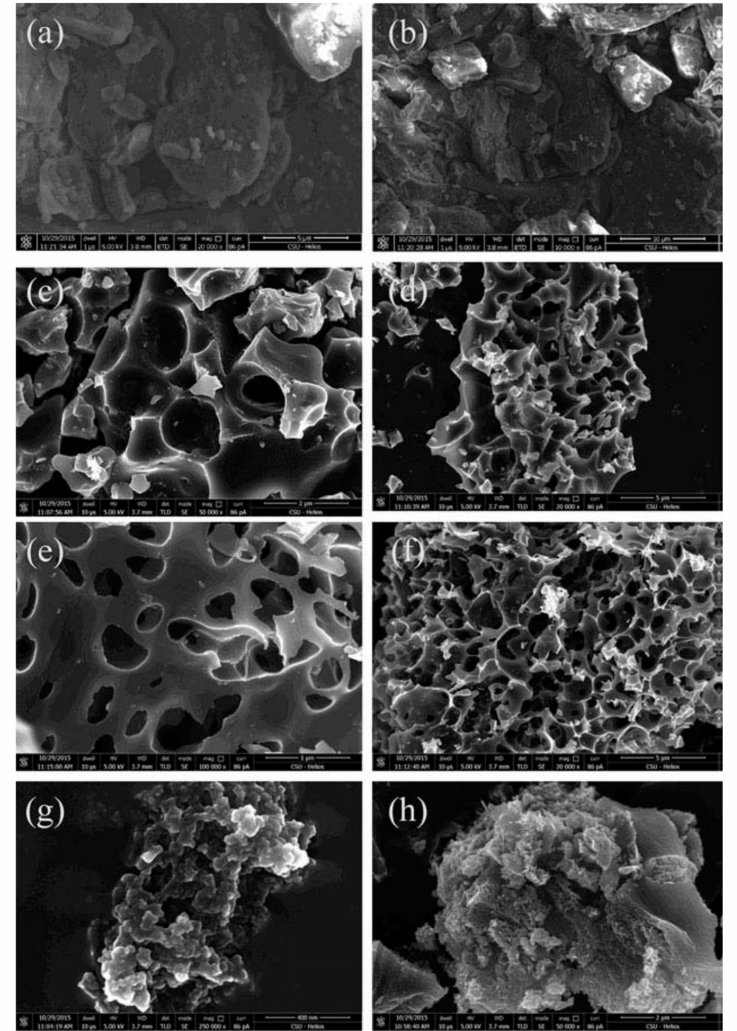
Figure 3. SEM images of ( a , b ) raw tobacco stem and AC samples: ( c , d ) activated with KOH, ( e , f ) activated with K 2 CO 3 , and ( g , h ) activated with ZnCl 2 [58]. Figure reproduced from reference [58] with permission from Taylor &